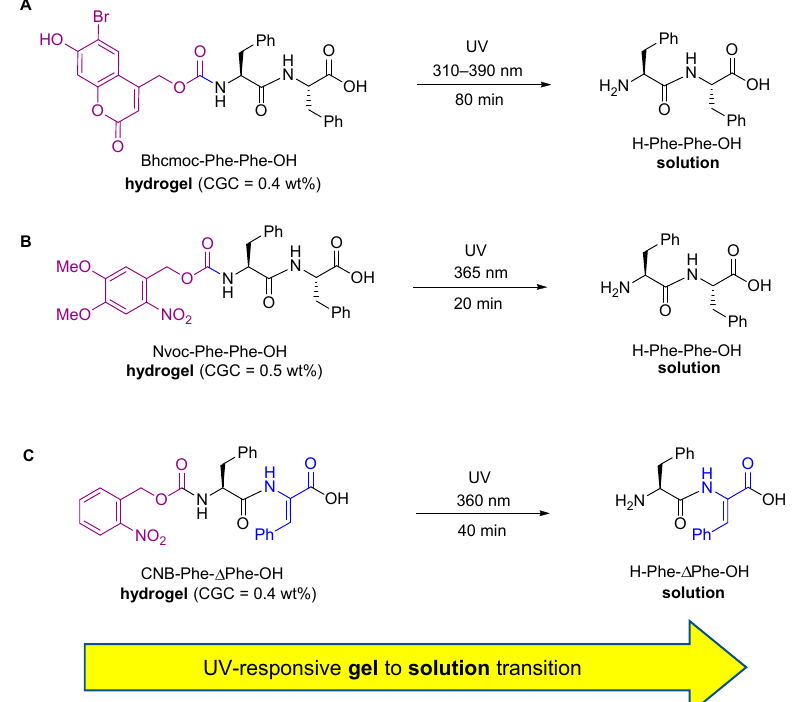
Figure 4. Sol-to-gel transitions of light-responsive hydrogels capped with photo-labile groups: ( A ) dipeptide capped with Bhcmoc; ( B ) dipeptide capped with Nvov; ( C ) dipeptide capped with CNB.